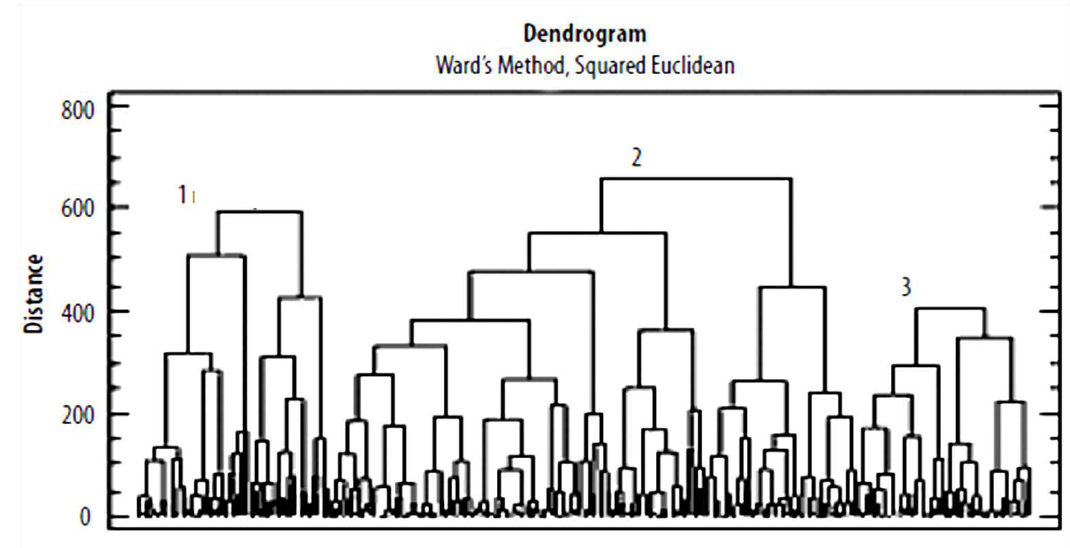
Figure 3. The result of the cluster analysis of the crisis resilience of restaurant business establishments in Lviv by Ward’s